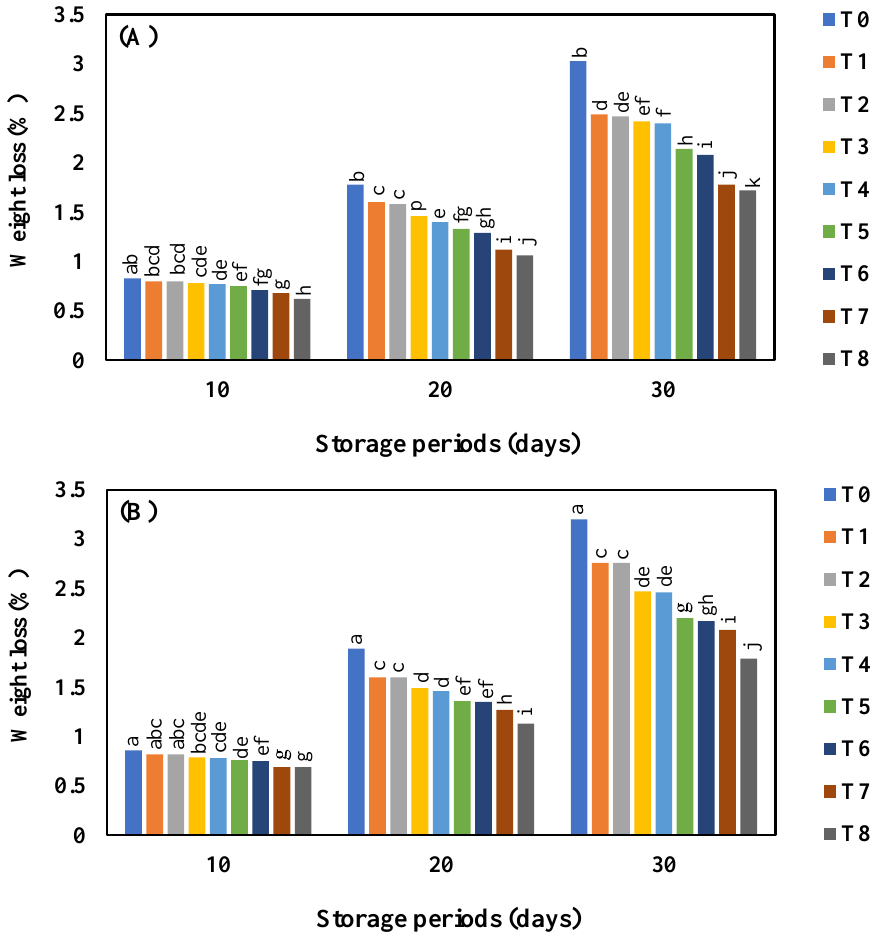
Figure 1. Effect of AgNO 3 and Ag-NPs on the weight loss (%) in Shine Muscat ( A ) and Kyoho ( B ) grape varieties during 30 days cold storage.